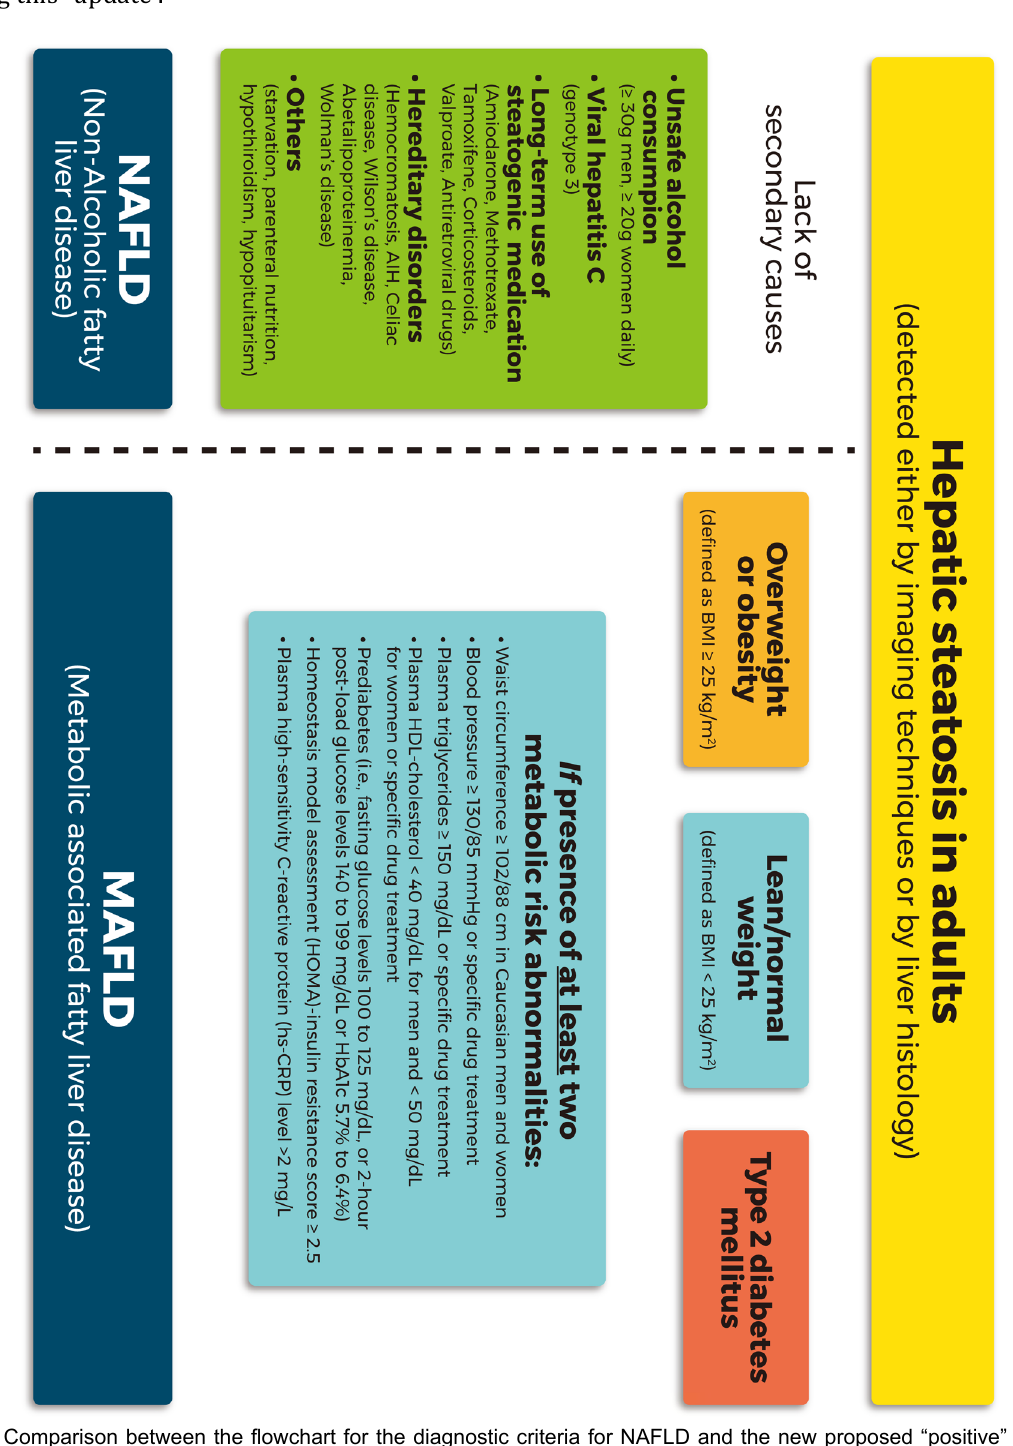
Explor Med. 2020;1:259-86 | https://doi.org/10.37349/emed.2020.00018